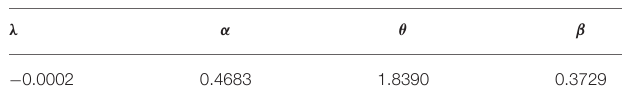
TABLE 12 | Calibrated parameters (NTS).